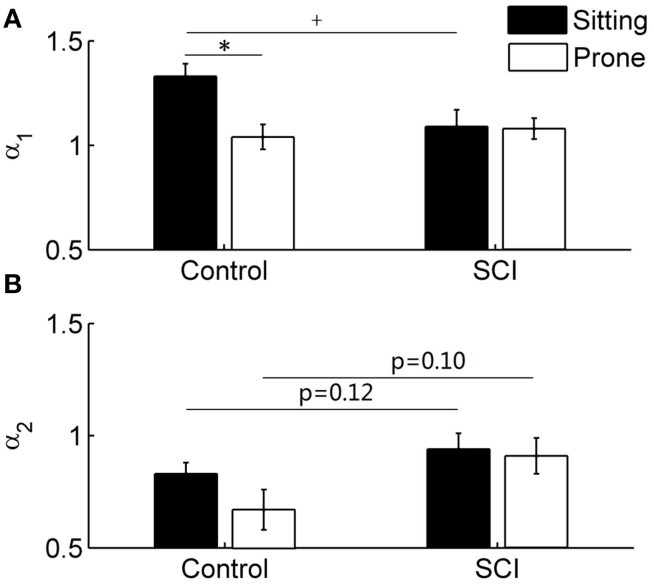
DFA coefficients α1 (short-term) and α2 (long-term) in able-bodied controls and subjects with SCI. Values are means ± SE. *p < 0.05 for within-subjects test; +p < 0.05 for between-subjects test. (A) α1 in control and SCI groups. (B) α2 in control and SCI groups.